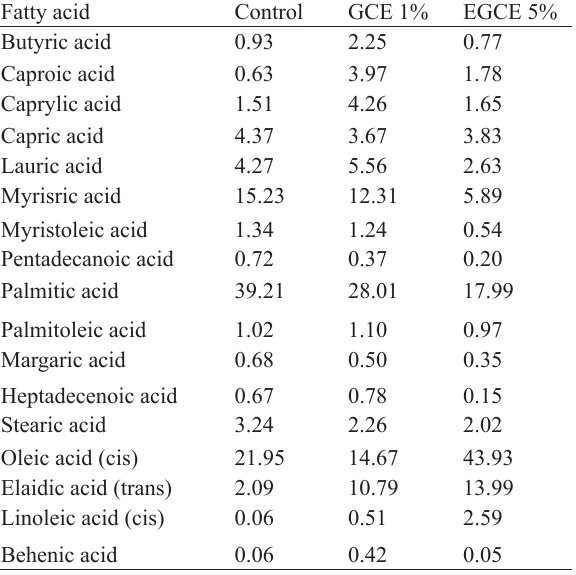
Table 3 Fatty acid composition of control, GCE 1% and EGCE 5% kashks, %